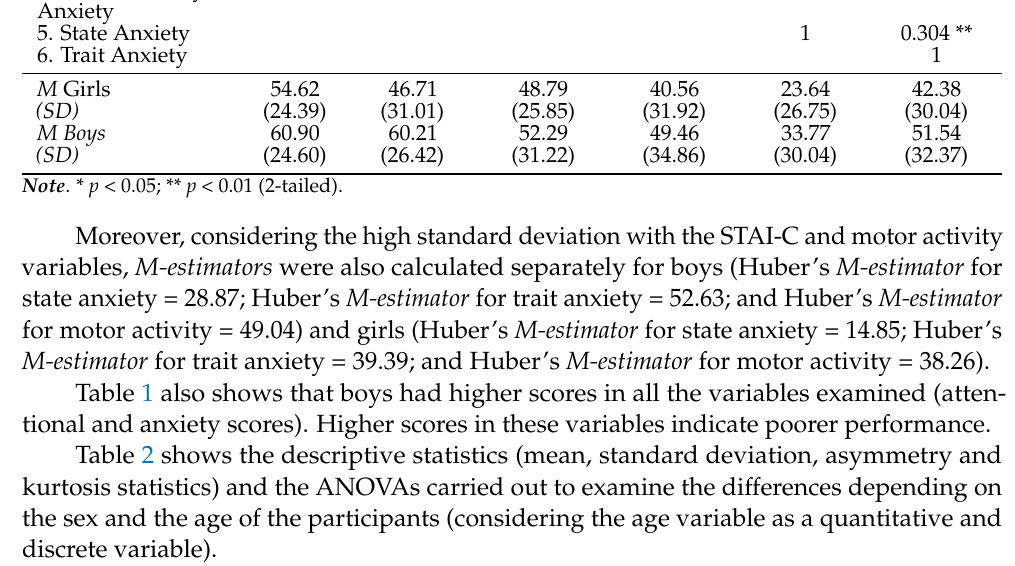
Table 2. Descriptive statistics and differences across age and sex for attentional variables and state/trait anxiety levels.